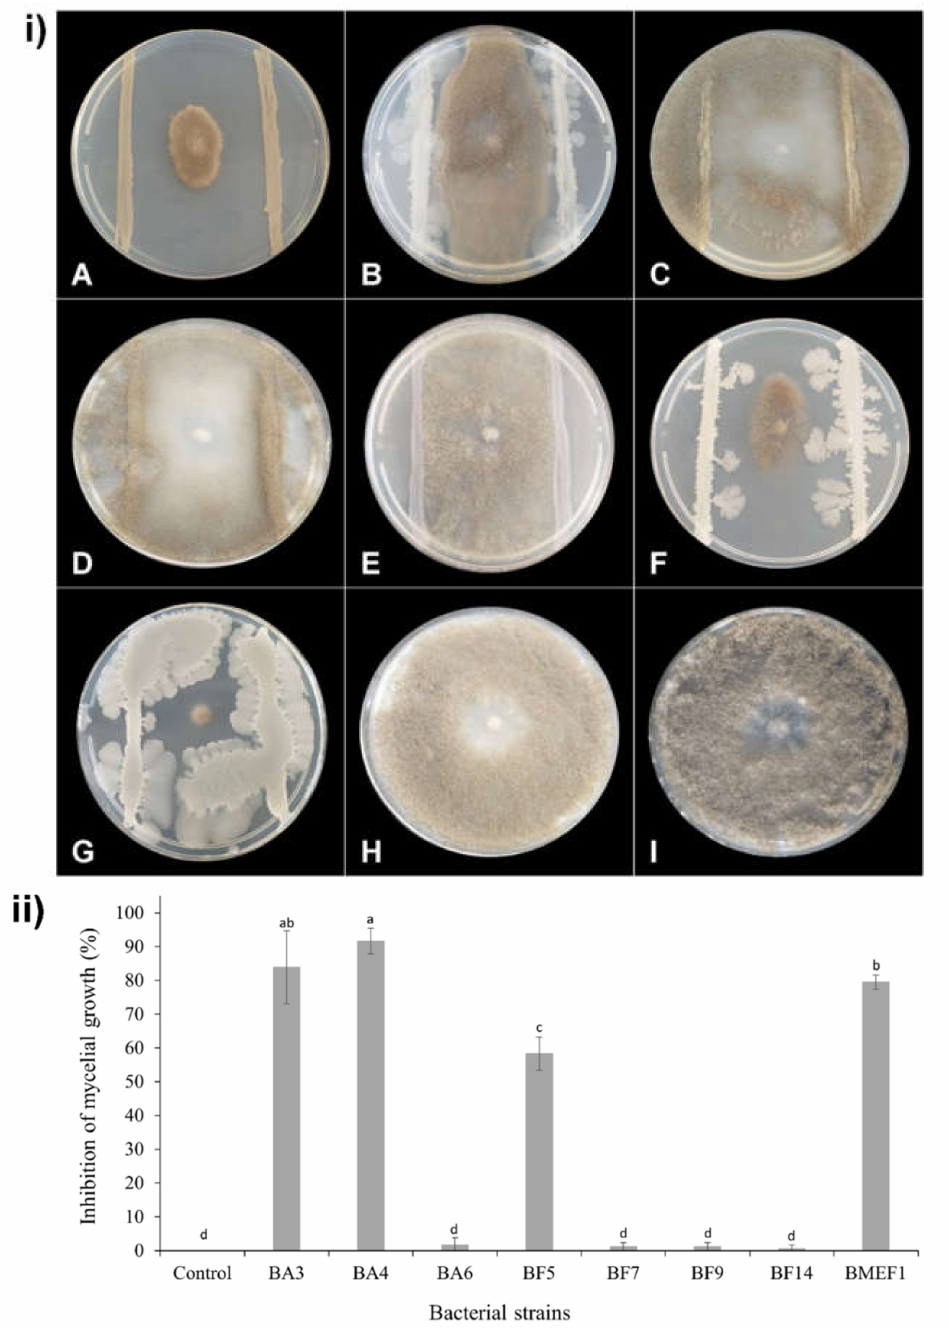
Figure 1. In vitro inhibitory activities of isolated bacteria against B. cinerea on PDA medium after 10 days of incubation at 25 ◦ C. ( i ) Plates inoculated with the pathogen and bacterial strains: Asaia spathodeae BMEF1 (A), Pseudomonas tremae BF5 (B), Microbacterium testaceum BF7 (C), Curtobacterium pusillum BF9 (D), Serratia marcescens BF14 (E), Bacillus velezensis BA3 (F), B. velezensis BA4 (G), Sph- ingomonas zeae BA6 (H), respectively. (I) Control plate inoculated only with B. cinerea . ( ii ) Growth inhibition of B. cinerea confronted with bacterial isolates in dual culture assay. Different letters above the bars indicate significant differences according to Tukey’s test ( p <